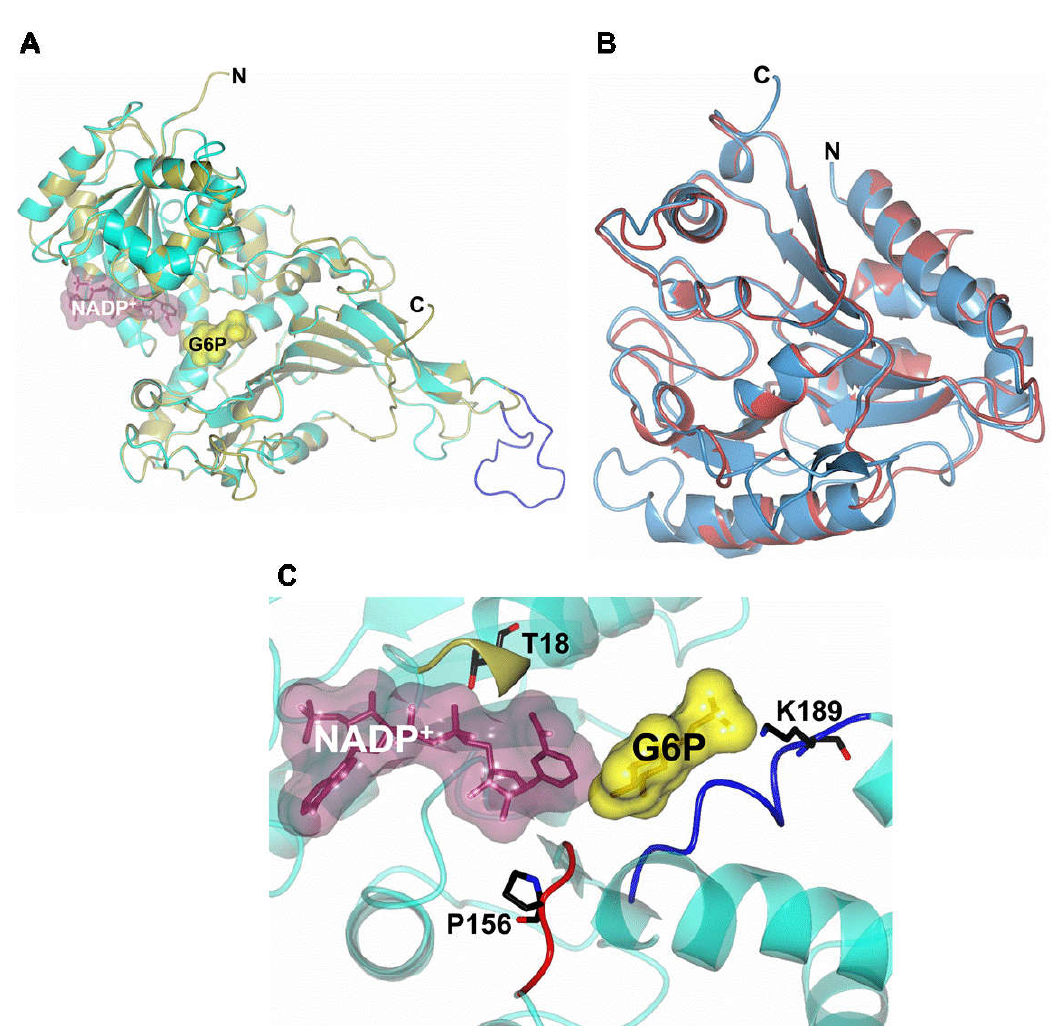
Figure 11. A homology model of the full-length G6PD::6PGL enzyme. ( A ) Structural superposition of the human G6PD crystal structure (PDB entry 2BH9, gold) with the region that codes for the G6PD enzyme (residues 1–515, cyan). Note that the G6PD structure from G. lamblia showed an extended loop (residues 386–407, blue) which is truncated in the human G6PD counterpart. ( B ) Structural superposition of the 6PGL crystal structure from L. guyanensis (PDB entry 3CSS; light blue) with the 6PGL enzyme (residues 516–742, pale crimson). ( C ) The G6PD active site showed the conserved sequences GxxGDLT (residues 12–18, gold), EKPxG (residues 154–158, red), and RIDHYLGKE (residues 182–190, blue). Representative residues (T18, P156, and K189) of these conserved sequences are shown as black cylinders. In all cases, the catalytic NADP + and G6P substrate (PDB entries 2BHL and 2BH9, respectively) are shown as dark purple and yellow molecular surface representations, respectively.